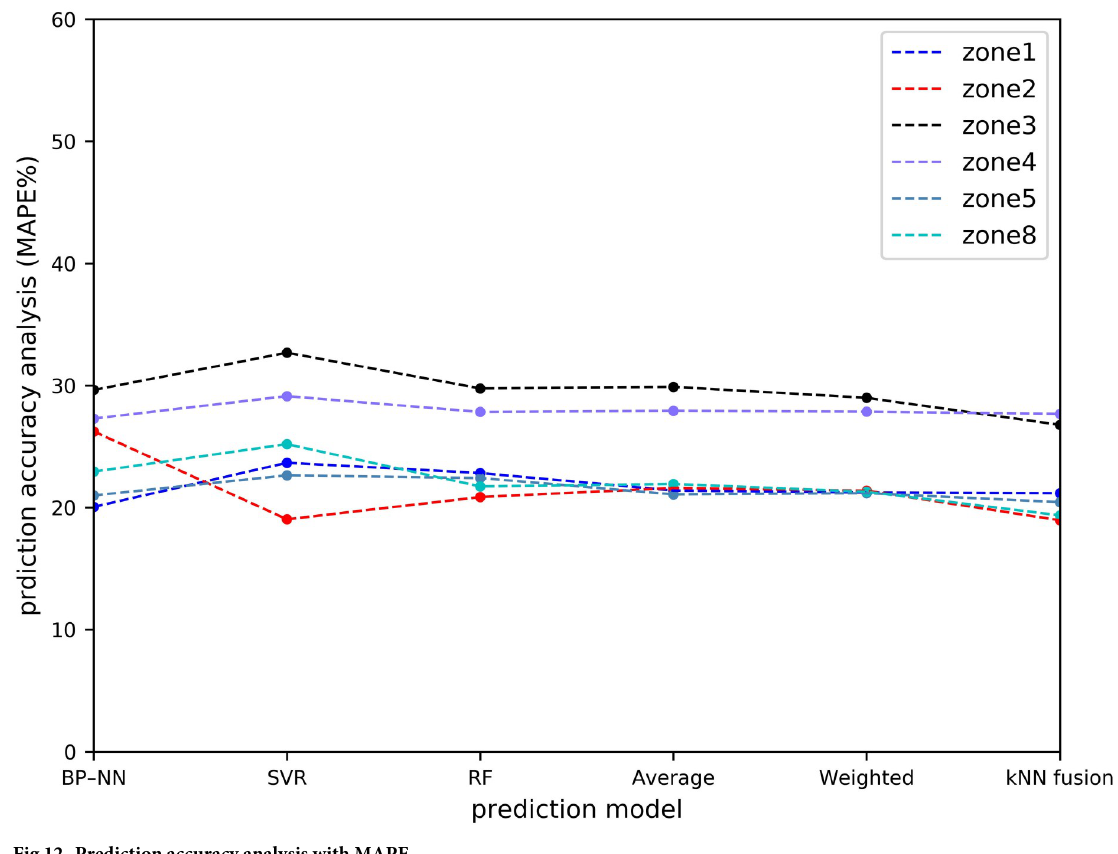
Fig 12. Prediction accuracy analysis with